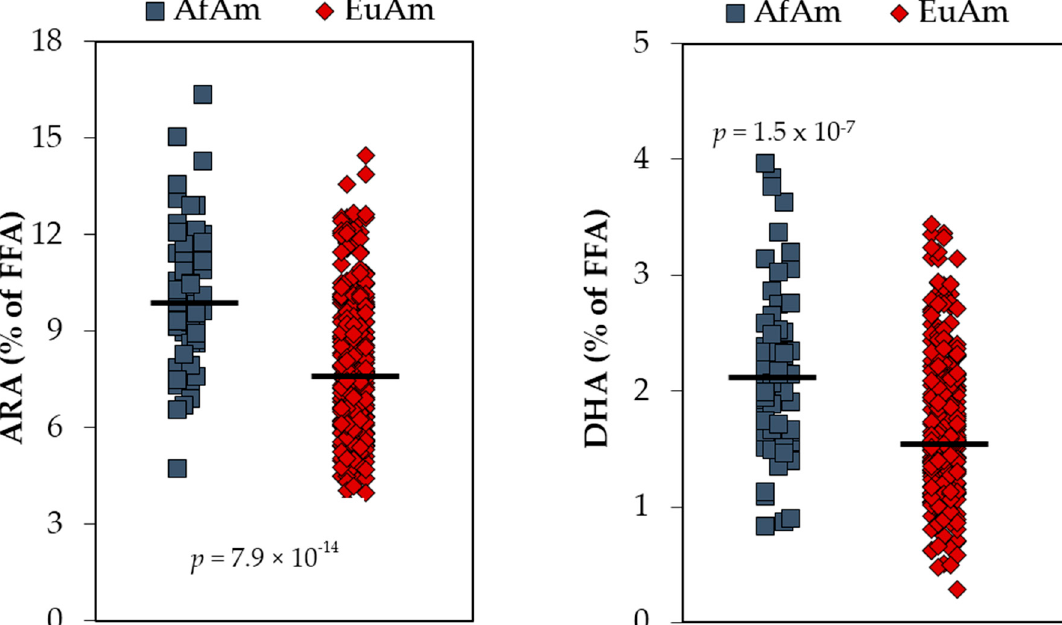
Figure 4. Serum Levels of ARA and DHA in African Americans (AfAm) and European Americans (EuAm). Both n -6 and n -3 LC-PUFAs (arachidonic acid, ARA; and docosahexaenoic acid, DHA) are elevated in serum from AfAm relative to EuAm from the same clinical diabetes study cohort [106].